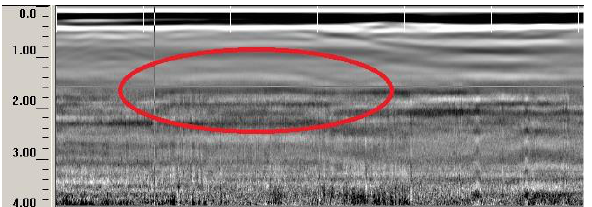
Figure 3. Scan of the ground penetrating radar where vaulted ceiling is being detected.